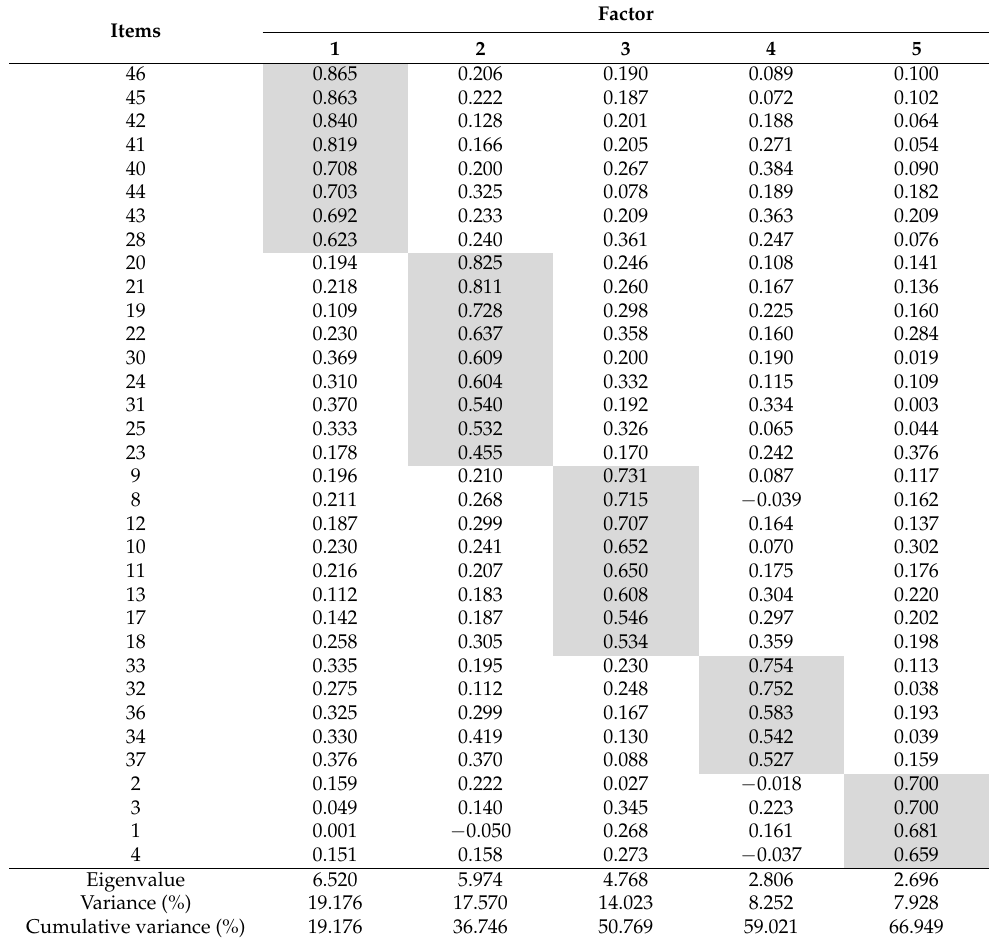
Table 2. Explanatory factor analysis ( N =